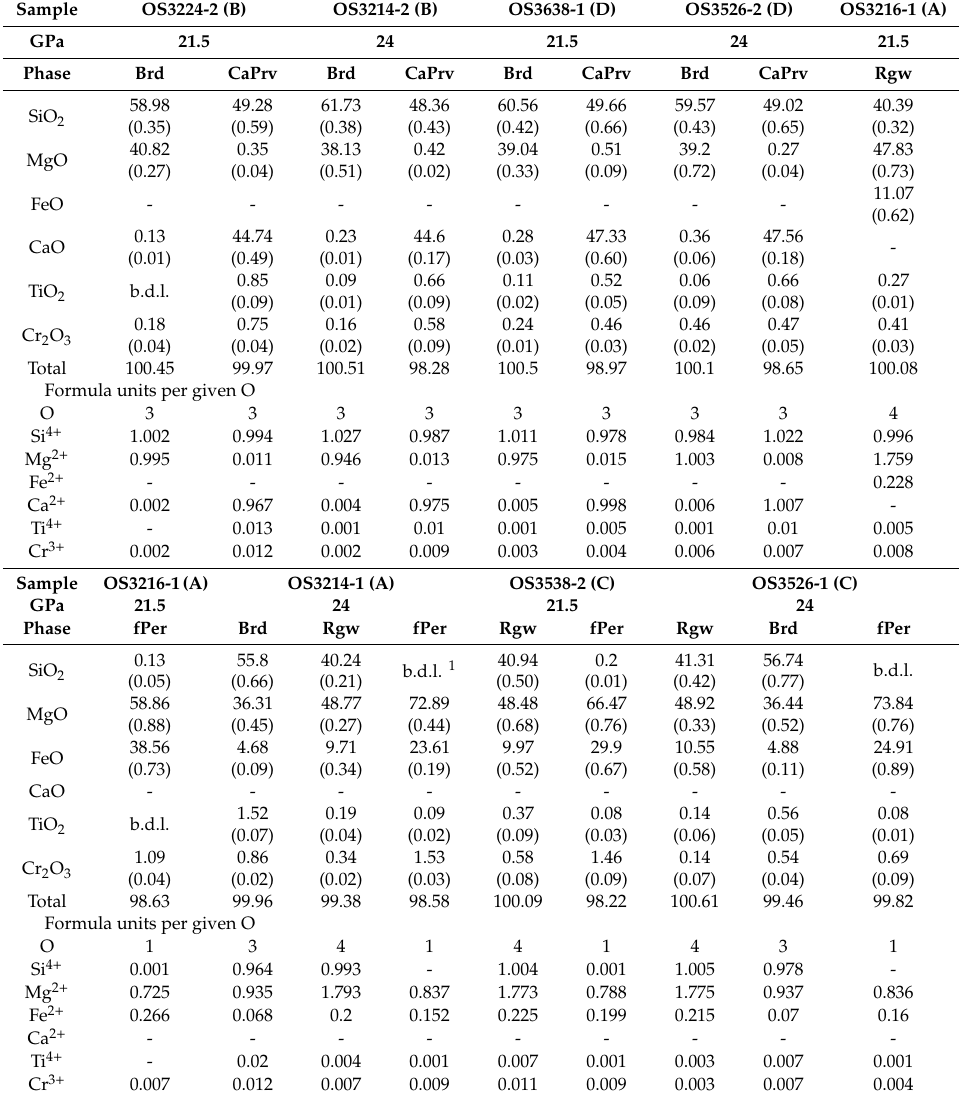
Table 1. Mean composition of phases produced in experiments at 21.5 and 24 GPa and 1600 ◦ C.